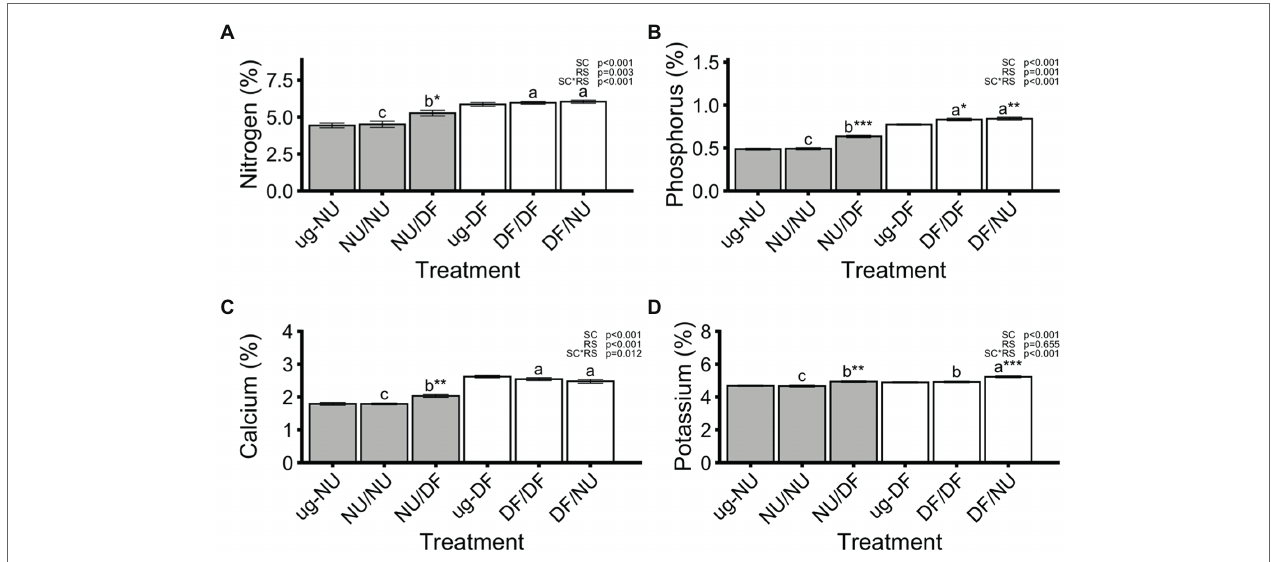
FIGURE 3 | Concentrations of nitrogen (A) , phosphorus (B) , calcium (C) , and potassium (D) in dry shoot tissue in the second trial. Values are means of 6 replicates for each treatment and error bars represent standard error. Asterisks above bars indicate significant difference between grafted treatment and the un-grafted control of the same scion cultivar by Dunnett’s test [***( p ≤ 0.001), **( p ≤ 0.01), and *( p ≤ 0.05)]. p -values indicate significance of scion (SC), rootstock (RS) and scion by rootstock interaction (SCxRS) effects from the factorial analysis of self- and inter-cultivar grafted plants (four treatments excluding un-grafted controls). Letters indicate mean separations for the four grafted treatments by Tukey’s HSD ( p ≤ 0.05) applied when SCxRS interaction was significant. Gray and white bars represent plants with NU and DF shoot systems,